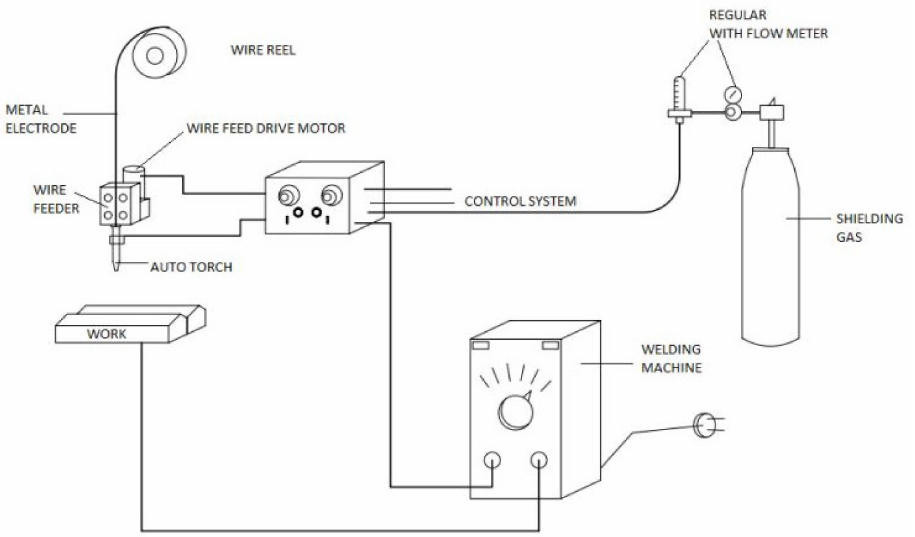
Figure 2. Layout of Gas Metal Arc Welding Machine.